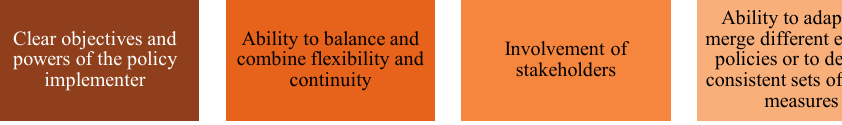
Fig. 1. Factors playing a key role in the process of developing and implementing energy efficiency policy